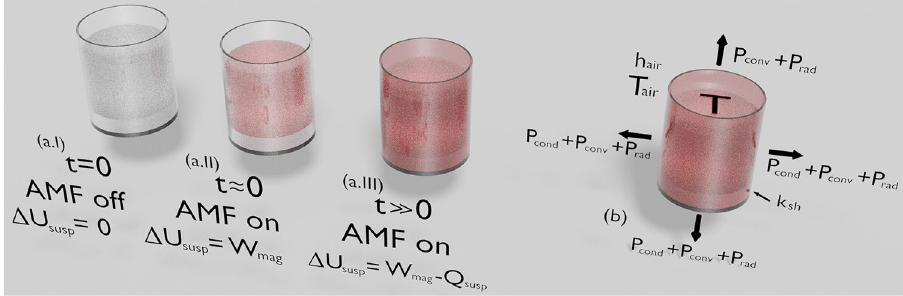
Figure 1. Schematic representation of our theoretical system—a suspension of magnetic nanoparticles inside a cylindrical sample holder, which is submitted to an alternating magnetic field. Suspension ( a.I ) in thermal equilibrium with the environment, ( a.II ) in an adiabatic regime during a short time interval just after the AMF is turned on, and ( a.III ) in the non-adiabatic regime. ( b ) Definitions of some quantities employed in our theoretical approach. Here, we consider T as the temperature of the suspension, and P cond as the heat loss rate due to the process of conduction through the walls of the sample holder, with κ sh denoting the thermal conductivity of the sample holder; P conv corresponds to the heat loss rate associated to the convection process of heat transfer from the outer surface of the sample holder and the upper surface of the sample, both surrounded by air; h air is the heat transfer coefficient of the air, and T air is the temperature of the environment; and finally P rad is heat loss rate due to the thermal